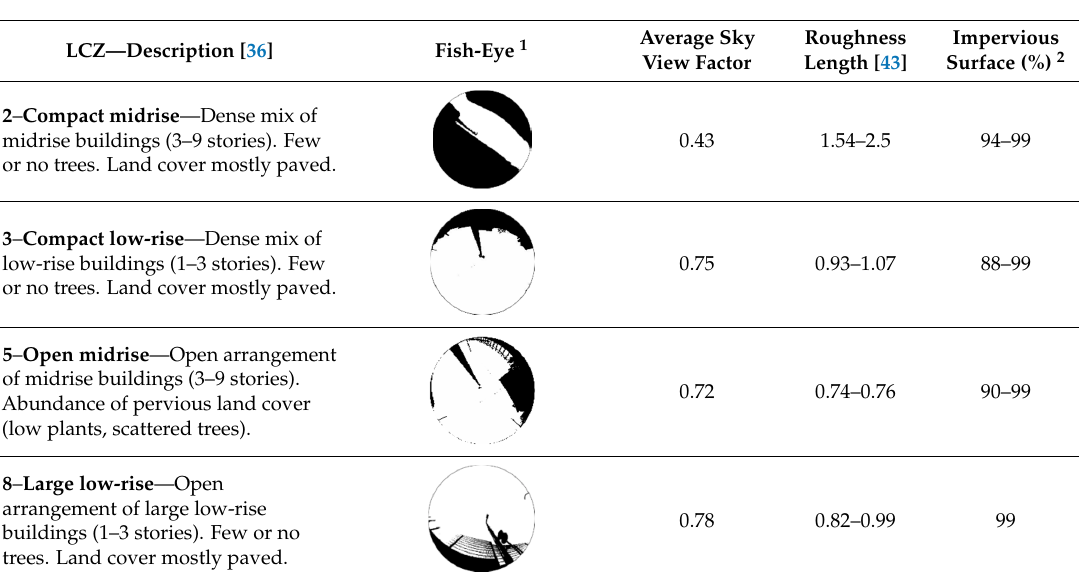
Table 2. Local Climate Zones and their attributes (Based on Stewart and Oke [36]).